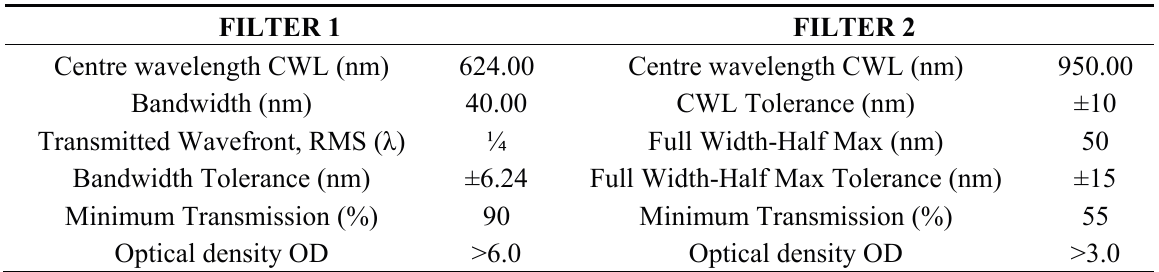
Table 2. Technical specifications of the selected